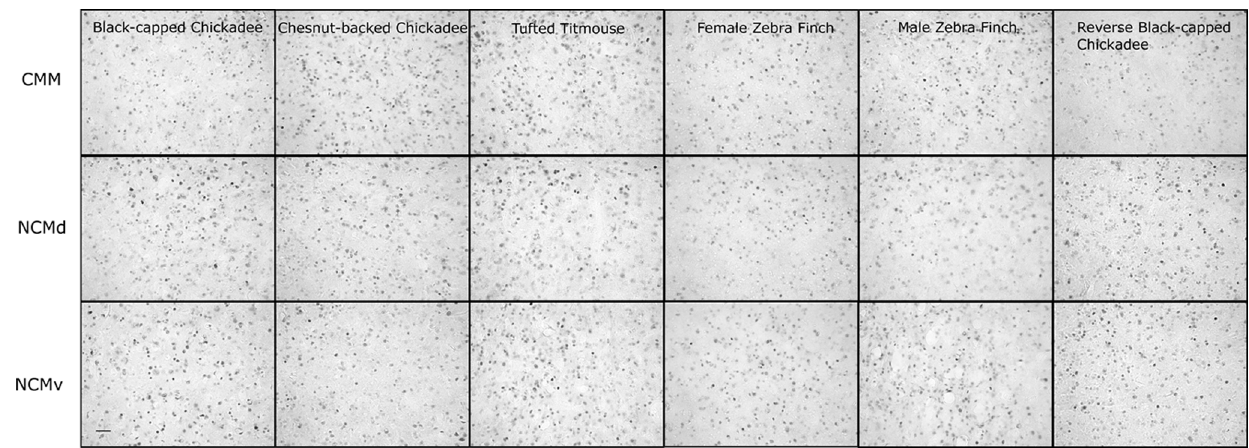
Figure 2. Example ZENK expression in CMM, NCMv, NCMd for each stimulus. Black-capped chickadee, chestnut-back chickadee, tufted titmouse, female zebra finch, male zebra finch, and reversed black-capped chickadee. Scale bar 50 m m.